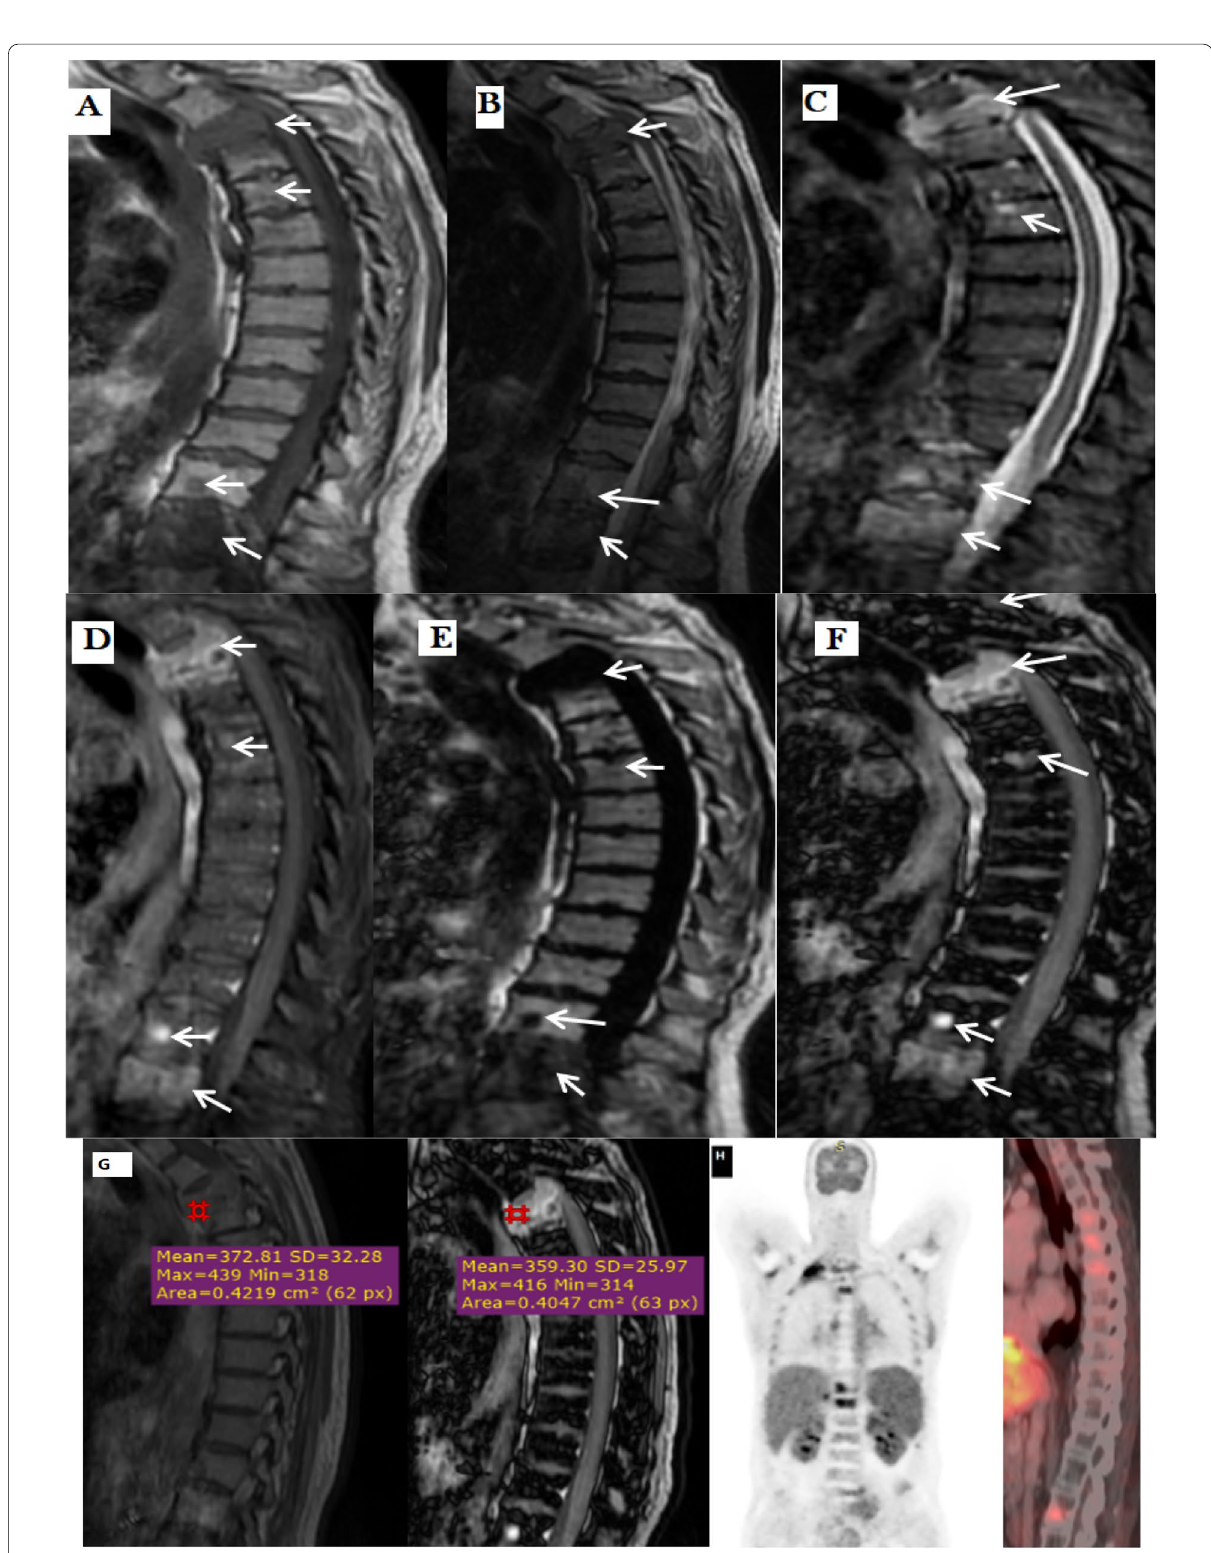
Fig. 2 A – H MRI and PET CT images of a 56-year-old male patient with a history of lung cancer A T1 FSE B T2 FSE C T2 WO Dixon, D T1 post-contrast WO Dixon, E T1 FO Dixon F T1 post-contrast OP Dixon, G IP/OP ratio MR images and H FDG PET CT show multiple dorsal vertebral metastasis with IP/OP ratio